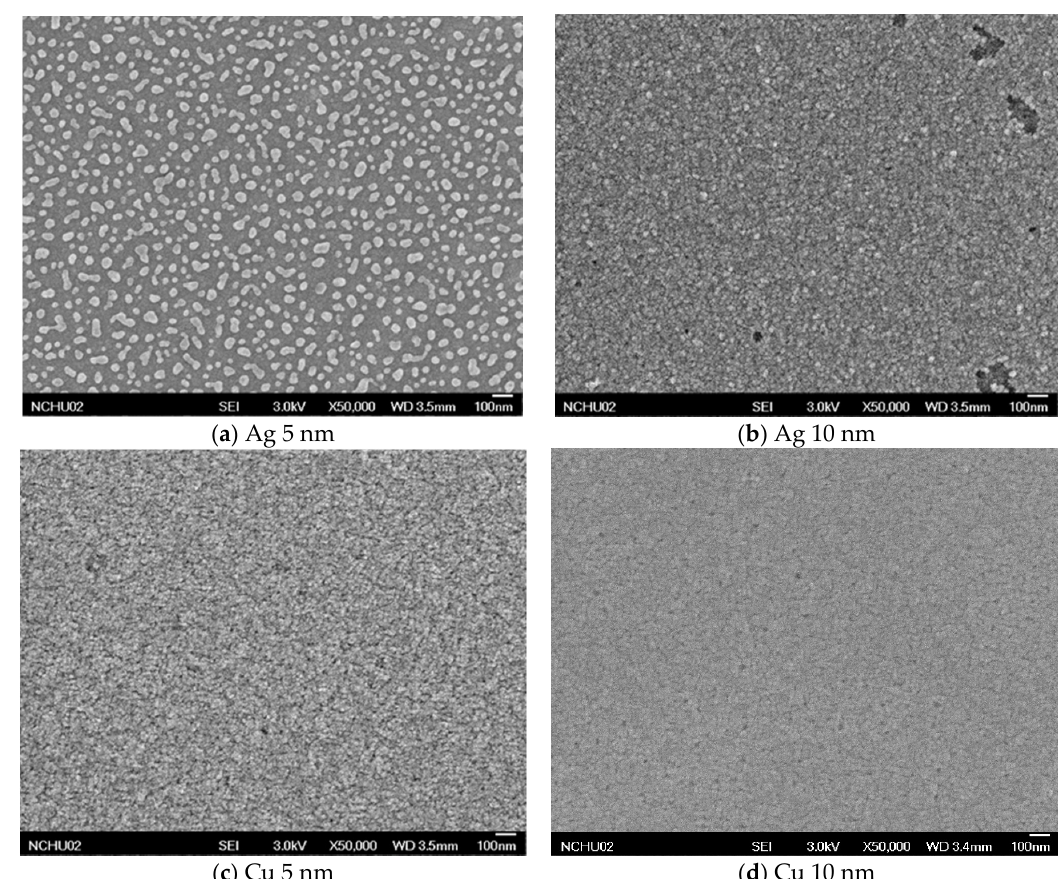
Figure 2. Surface FESEM images of Ag ( a , b ) and Cu ( c , d ) layers with thicknesses of 5 and 10 nm grown on the bottom ITO layer deposited on the PEN substrate.